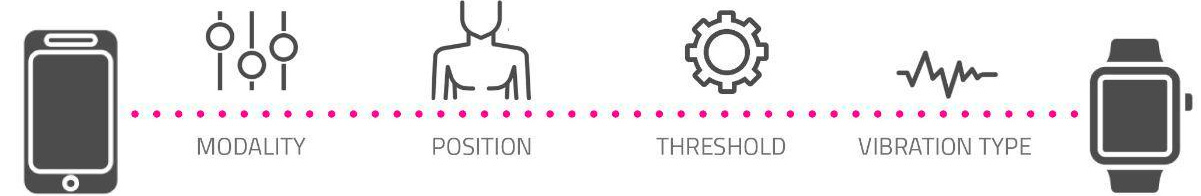
Figure 8. System scheme showing data transmitted from the smartphone to the SW.